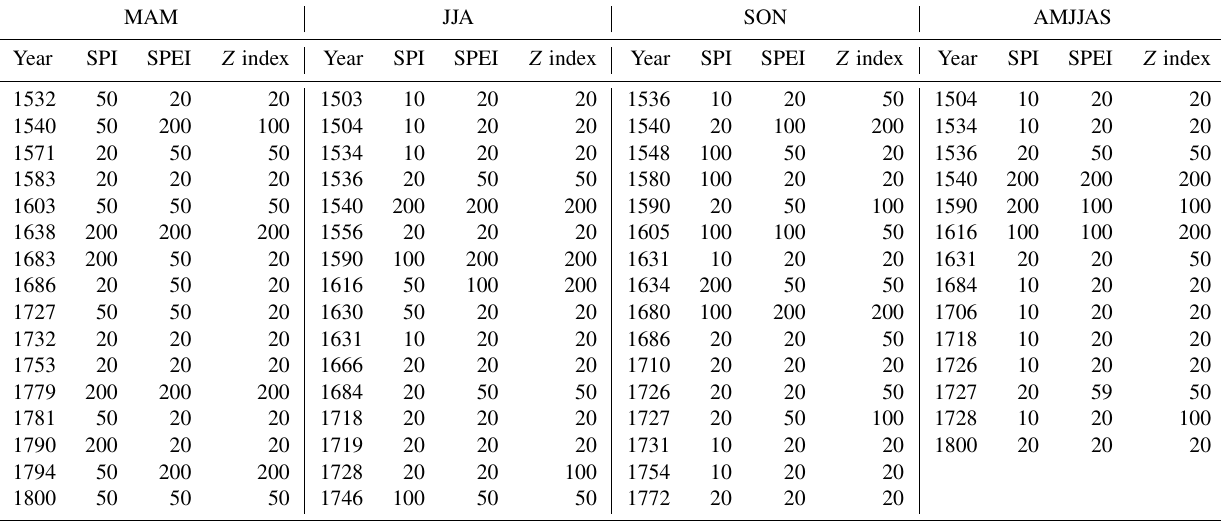
Table 1. Overview of seasonal (MAM, JJA, SON) and summer half-year (AMJJAS) extreme droughts in the Czech Lands, selected according to series of SPI, SPEI and Z index with a return period of N ≥ 20 years ( N ≥ 10 years for SPI) in the pre-instrumental 1501–1803